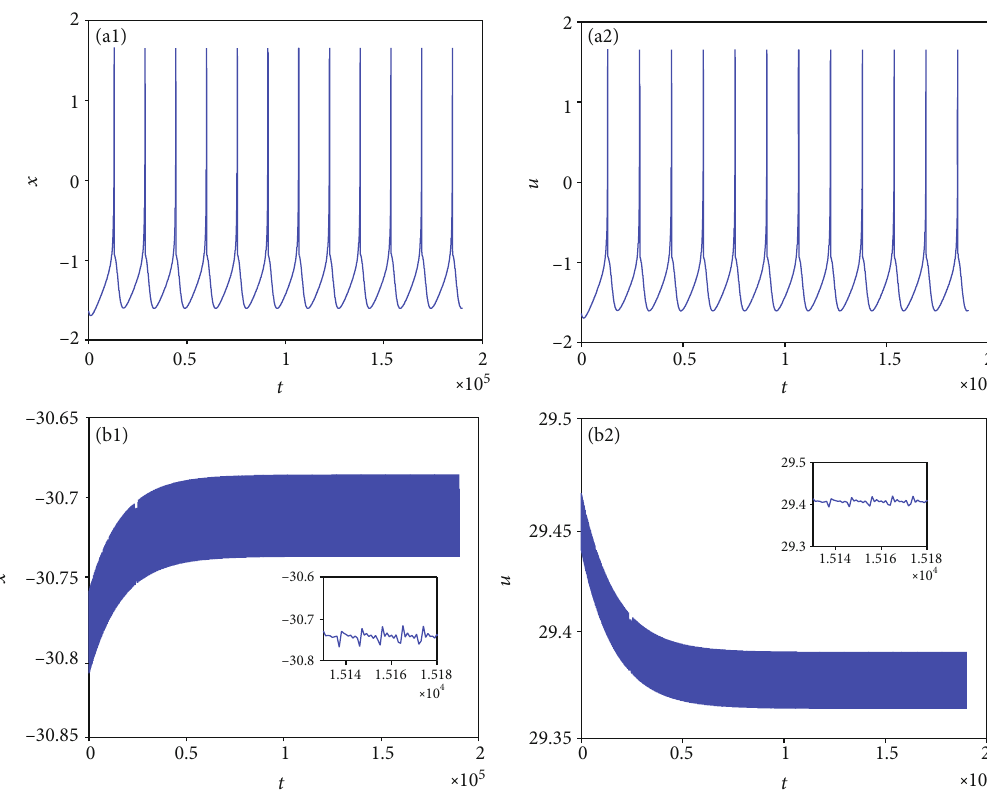
Figure 13: Multiple fi ring patterns of membrane potentials in model (2) when k = 0 : 5 and I ð 0, 0, 0, 0, 0, 0, 0 Þ . (b1 and b2) Time series for initial value ð − 2, 0, 0, 2, 0, 0, 0 Þ .